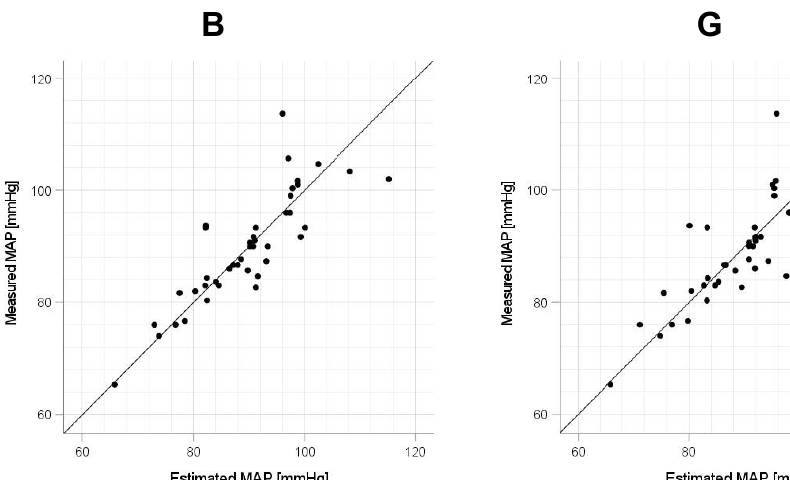
Figure 7. Accuracy of diastolic blood pressure (DBP) estimation at each wavelength. Scatterplots of DBP estimated using proposed method and DBP measured with a cuff sphygmomanometer ( N = 42). From left to right, the light source wavelengths are blue (B), green (G), red (R), and near-infrared (NIR). The solid line on each scatterplot is the regression line with geometric mean regression.